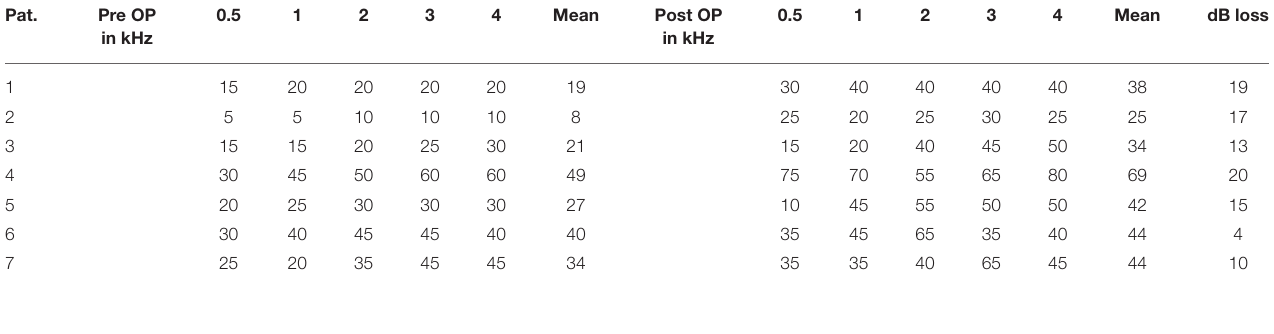
TABLE 2 | Individual PTA data (BC). Pat.